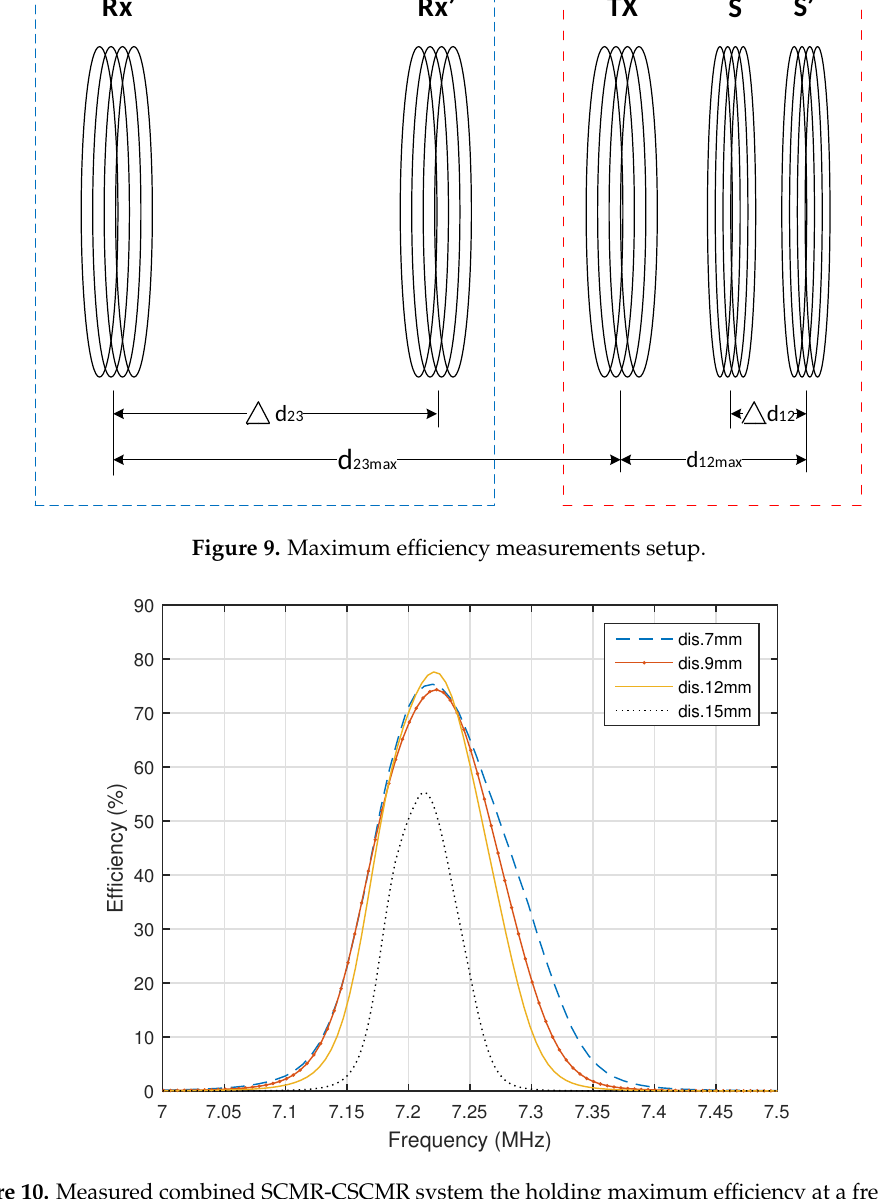
Figure 10. Measured combined SCMR-CSCMR system the holding maximum efficiency at a frequency of 7.23